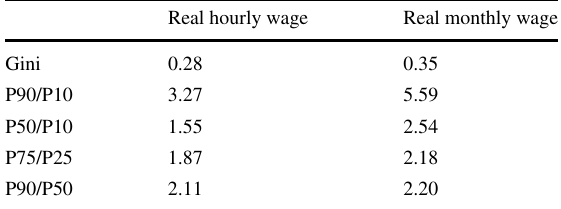
Real hourly wage Real monthly